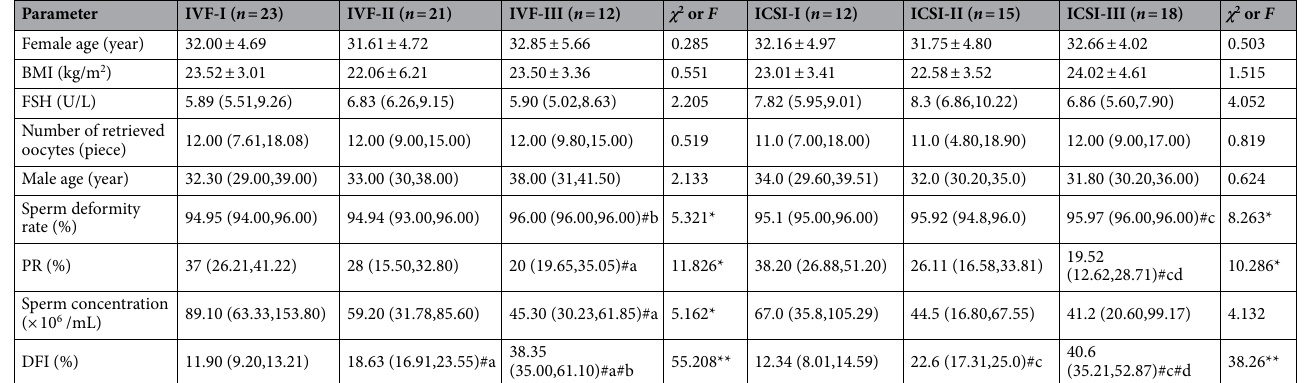
Table 3. Comparison of basic characteristics, semen parameters and malformation rate between three subgroups. ** P < 0.01, * P < 0.05; Data in the table are expressed as x ± S or M (P 25 , P 75 ). #a: compared with IVF-I group, #b: compared with IVF-II group, #c: compared with ICSI-I group, #d: compared with ICSI-II group, P < 0.05. According to DFI levels, IVF group was subdivided into IVF-I group (DFI ≤